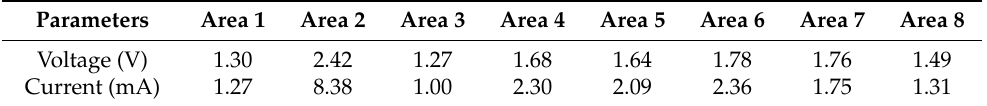
Table 2. Current and voltage of the powersphere.